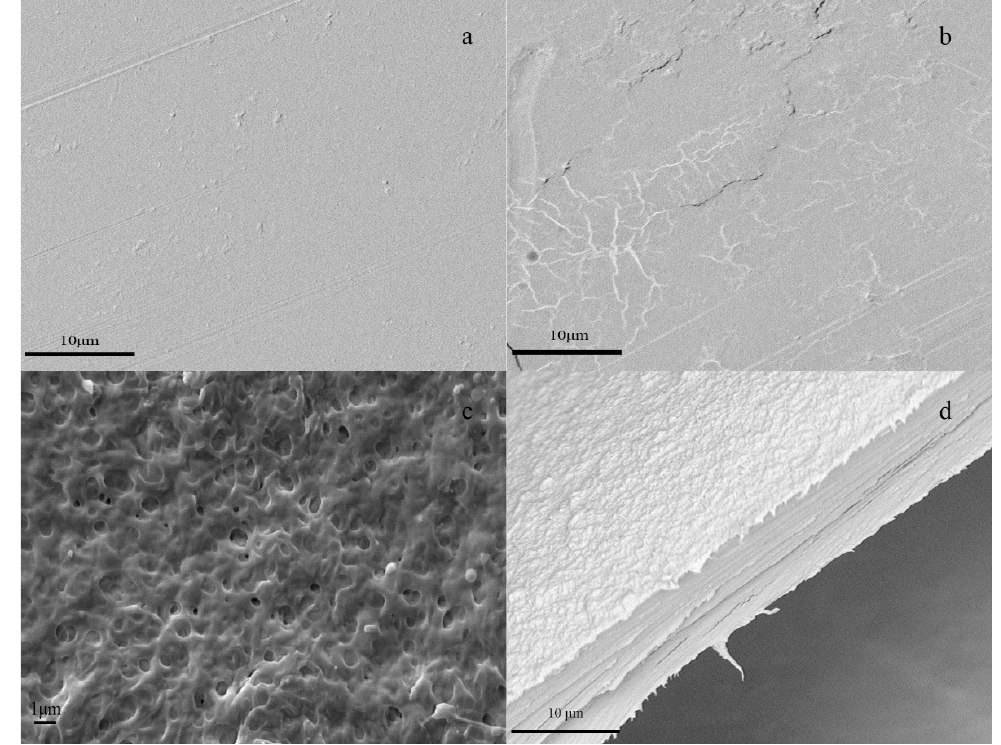
Figure 4. SEM of PPI membrane ( a ), PPI ‐ 3 ( b ), PPI ‐ 22 ( c ) and cross ‐ section of PPI membrane ( d ).